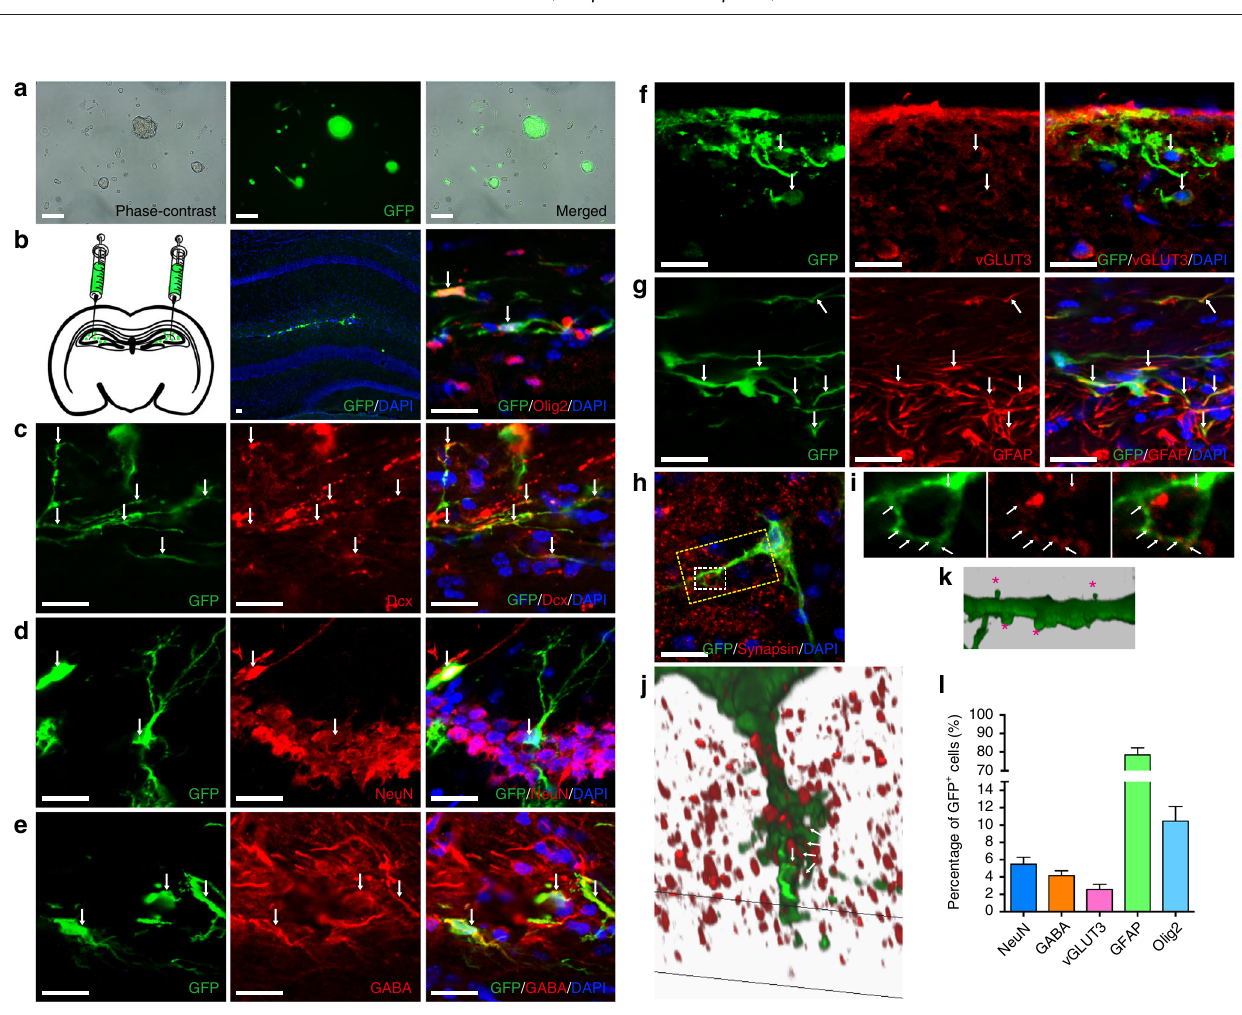
Fig. 4 In vitro differentiation potential of Ptf1a-reprogrammed miNSCs. a Schematic showing that miNSCs reprogrammed directly from MEFs by Ptf1a are able to differentiate into neurons, astrocytes, and oligodendrocytes under proper culture conditions. b miNSC10 cells underwent drastic morphological changes to form neuron-like cells when the culture medium was switched from NSC medium to neural differentiation medium. c miNSC10 cells could be differentiated into neurons immunoreactive for Tuj1, Map2, Dcx, NeuN, Tau, Peripherin, or GABA. They were also capable of differentiating into astrocytes (immunoreactive for GFAP) and oligodendrocytes (immunoreactive for O1, CNP, or MBP). d In vitro differentiated neurons were immunoreactive for both Tuj1 and synapsin. Cells in c and d were counterstained with nuclear DAPI. e Quanti fi cation of Map2 + neurons, GFAP + astrocytes, and O1 + oligodendrocytes differentiated from miNSC10 cells under different differentiation conditions. f A merged micrograph showing a typical GFP-tagged neuron differentiated from miNSCs that was chosen for patch-clamp recording. g Voltage-clamp recordings indicated fast activated and inactivated inward sodium currents as well as outward potassium currents on a differentiated neuron. h Current-clamp recordings revealed action potential responses of the differentiated neuron under current injection. i Multiple action potentials were induced after depolarization of the neuron. j Spontaneous postsynaptic currents recorded from an in vitro differentiated neuron. Scale bars, 80 μ m ( b ) and 40 μ m ( c , d